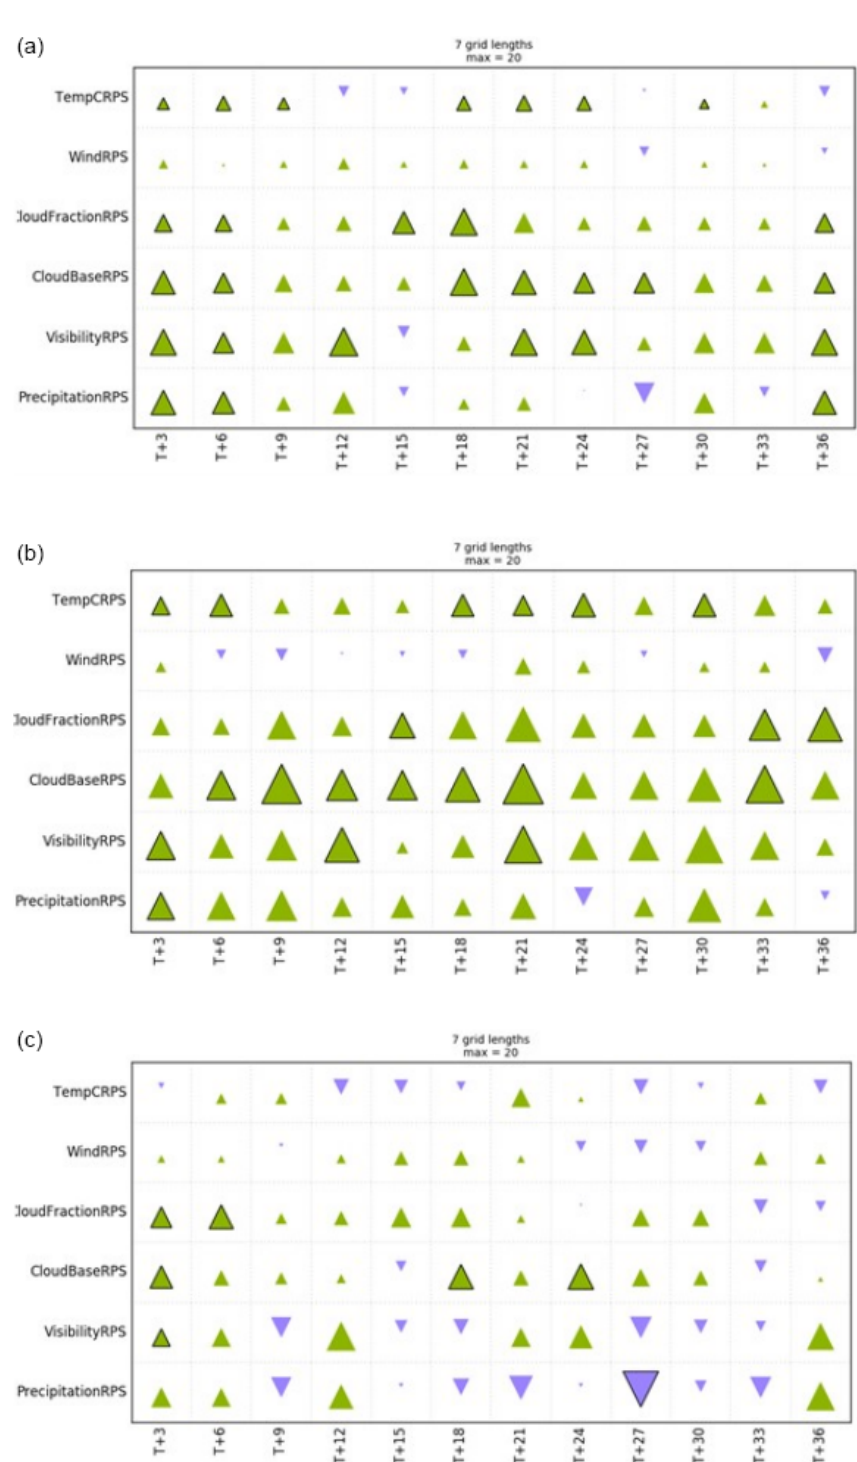
Figure 9. UKV case studies: RAL2-M vs. RAL1-M HiRA summary scorecard at 10.5km (seven grid lengths) spatial scale. Panel (a) shows results for all cases. The seasonal dependence is explored by stratifying the cases into winter cases (b) and summer cases (c)